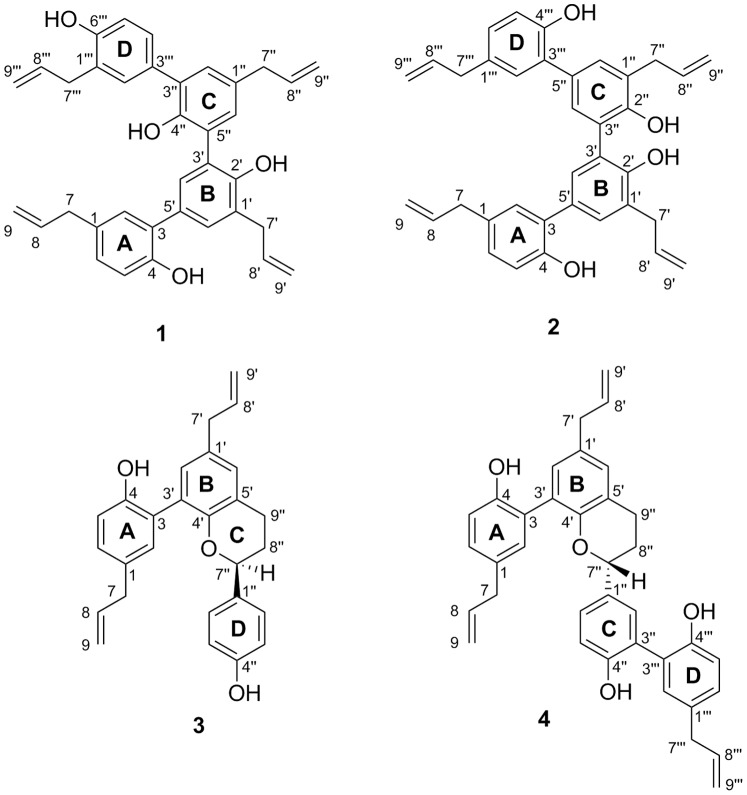
Structures of 1–4.